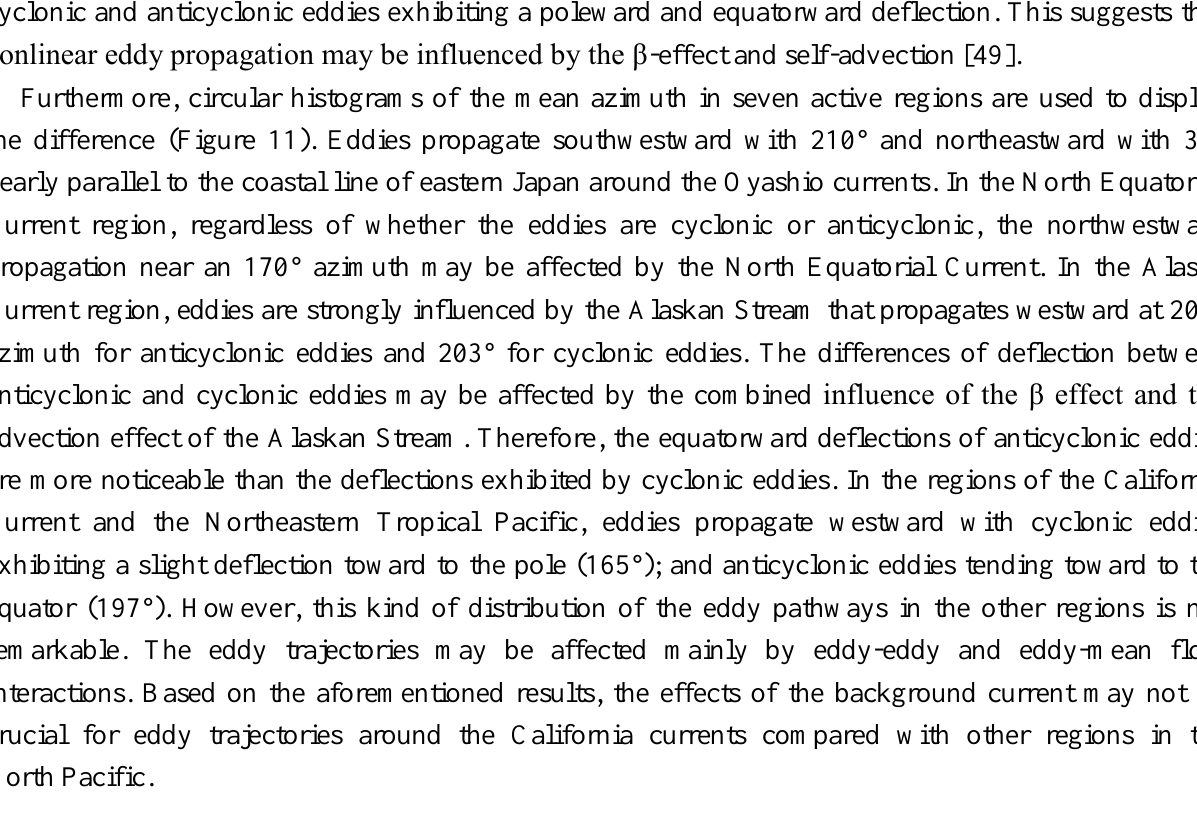
Figure 10. The maps of the mean azimuth relative to the eastern anticyclonic ( a ) and cyclonic eddies ( b